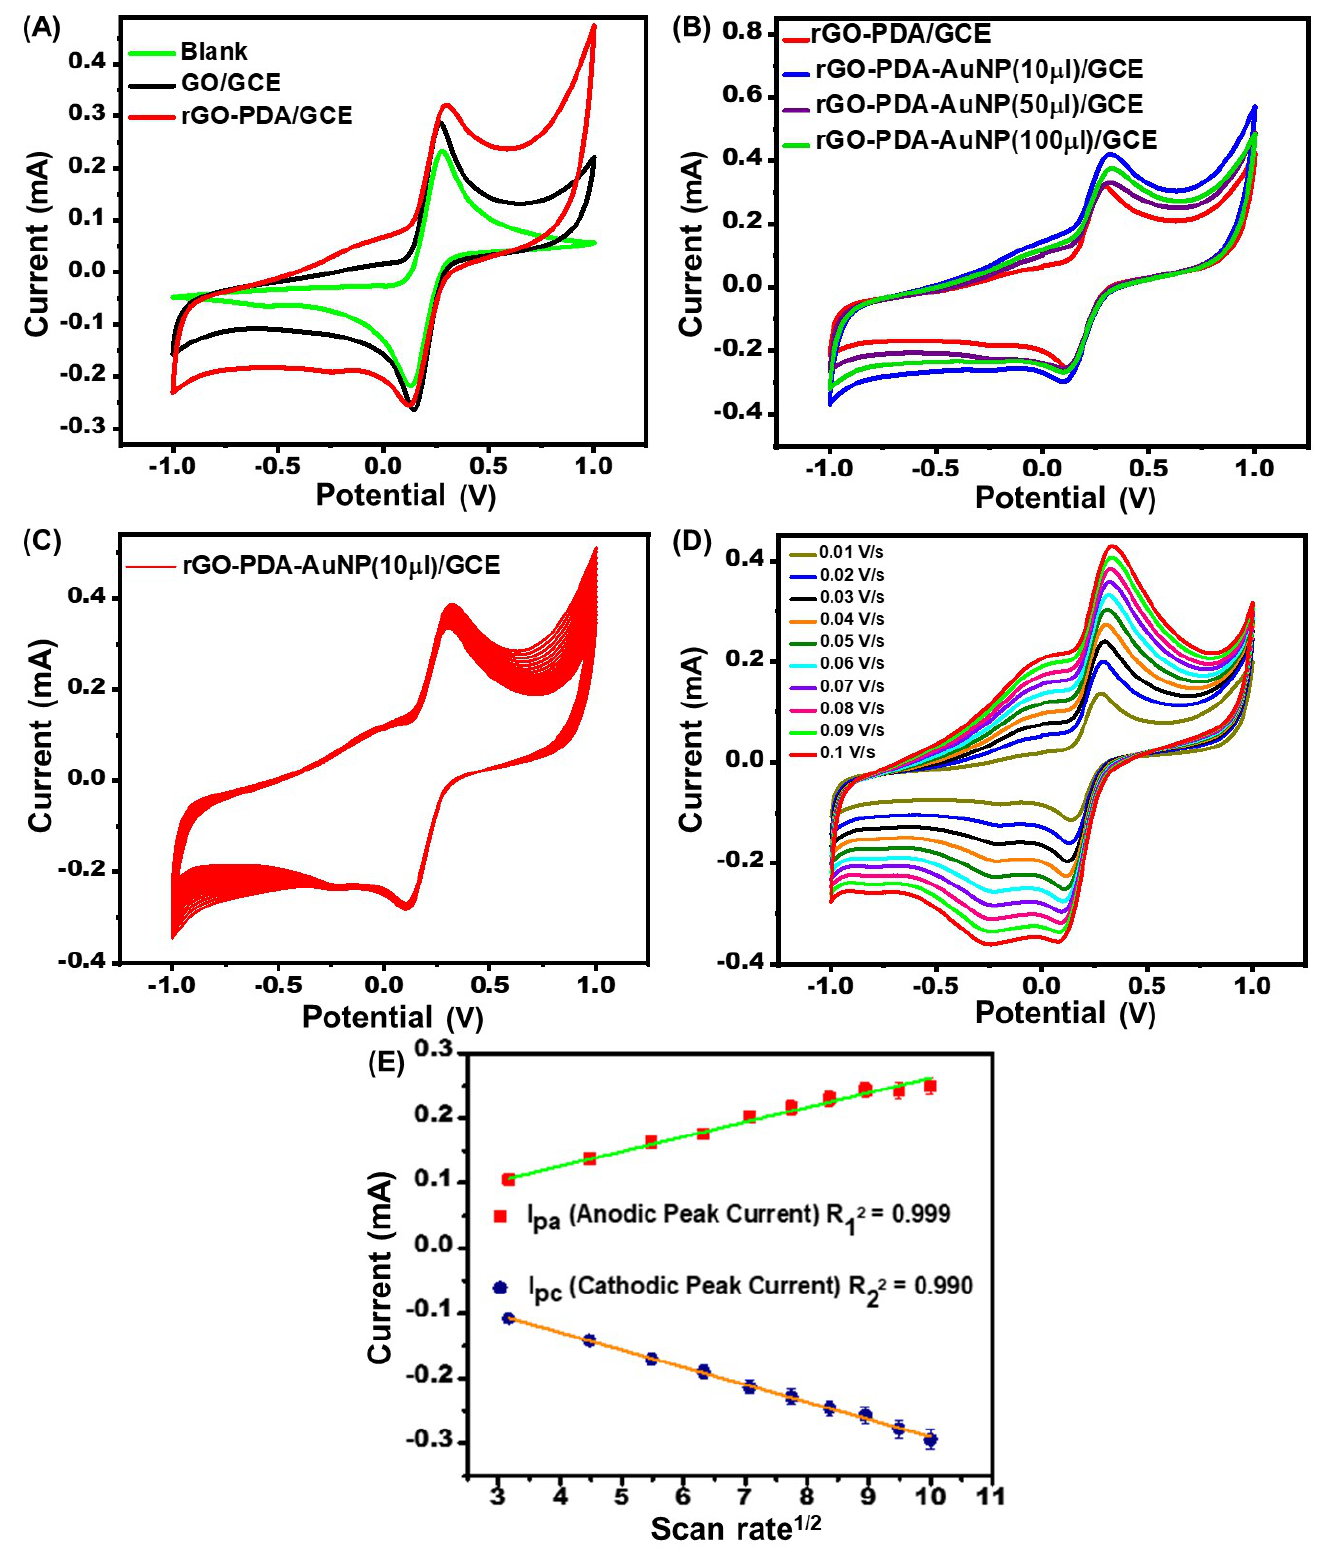
Figure 4. Cyclic voltammograms showing ( A ) comparison in electrochemical response of bare Figure 5. This is a figure. Schemes follow the same formatting. If there are multiple panels, they GCE, GO/GCE, and rGO-PDA/GCE; ( B ) modified electrode with 10 µ L, 50 µ L, and 100 µ L AuNP; should be listed as: ( a ) Description of what is contained in the first panel. ( b ) Description of what is ( C ) 20 cycle stability curve of rGO-PDA-AuNP/GCE; ( D ) electrochemical response of rGO-PDA- contained in the second panel. Figures should be placed in the main text near to the first time they AuNP/GCE at various scan rates; and ( E ) linear plot of current vs. square root of scan are cited. A caption on a single line should be centered.